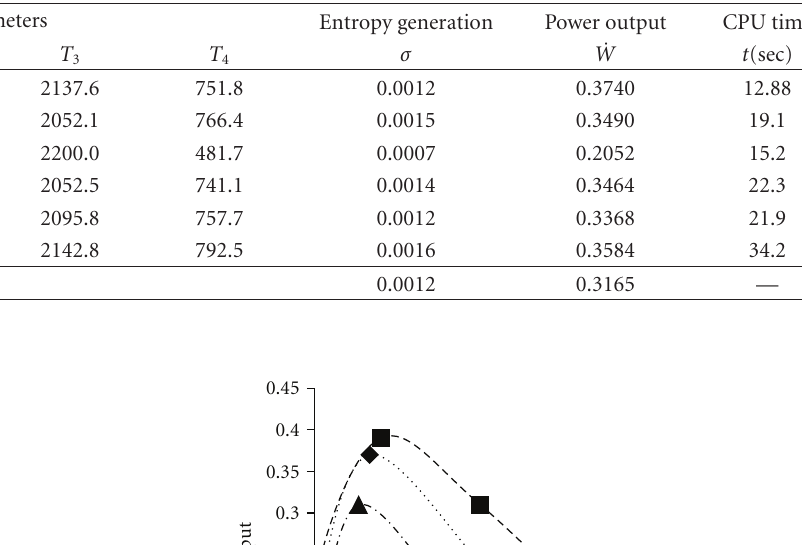
Table 4: Performance of tested algorithm in γ 0 = 1 . 36 and k 1 = 0 . 00006 .